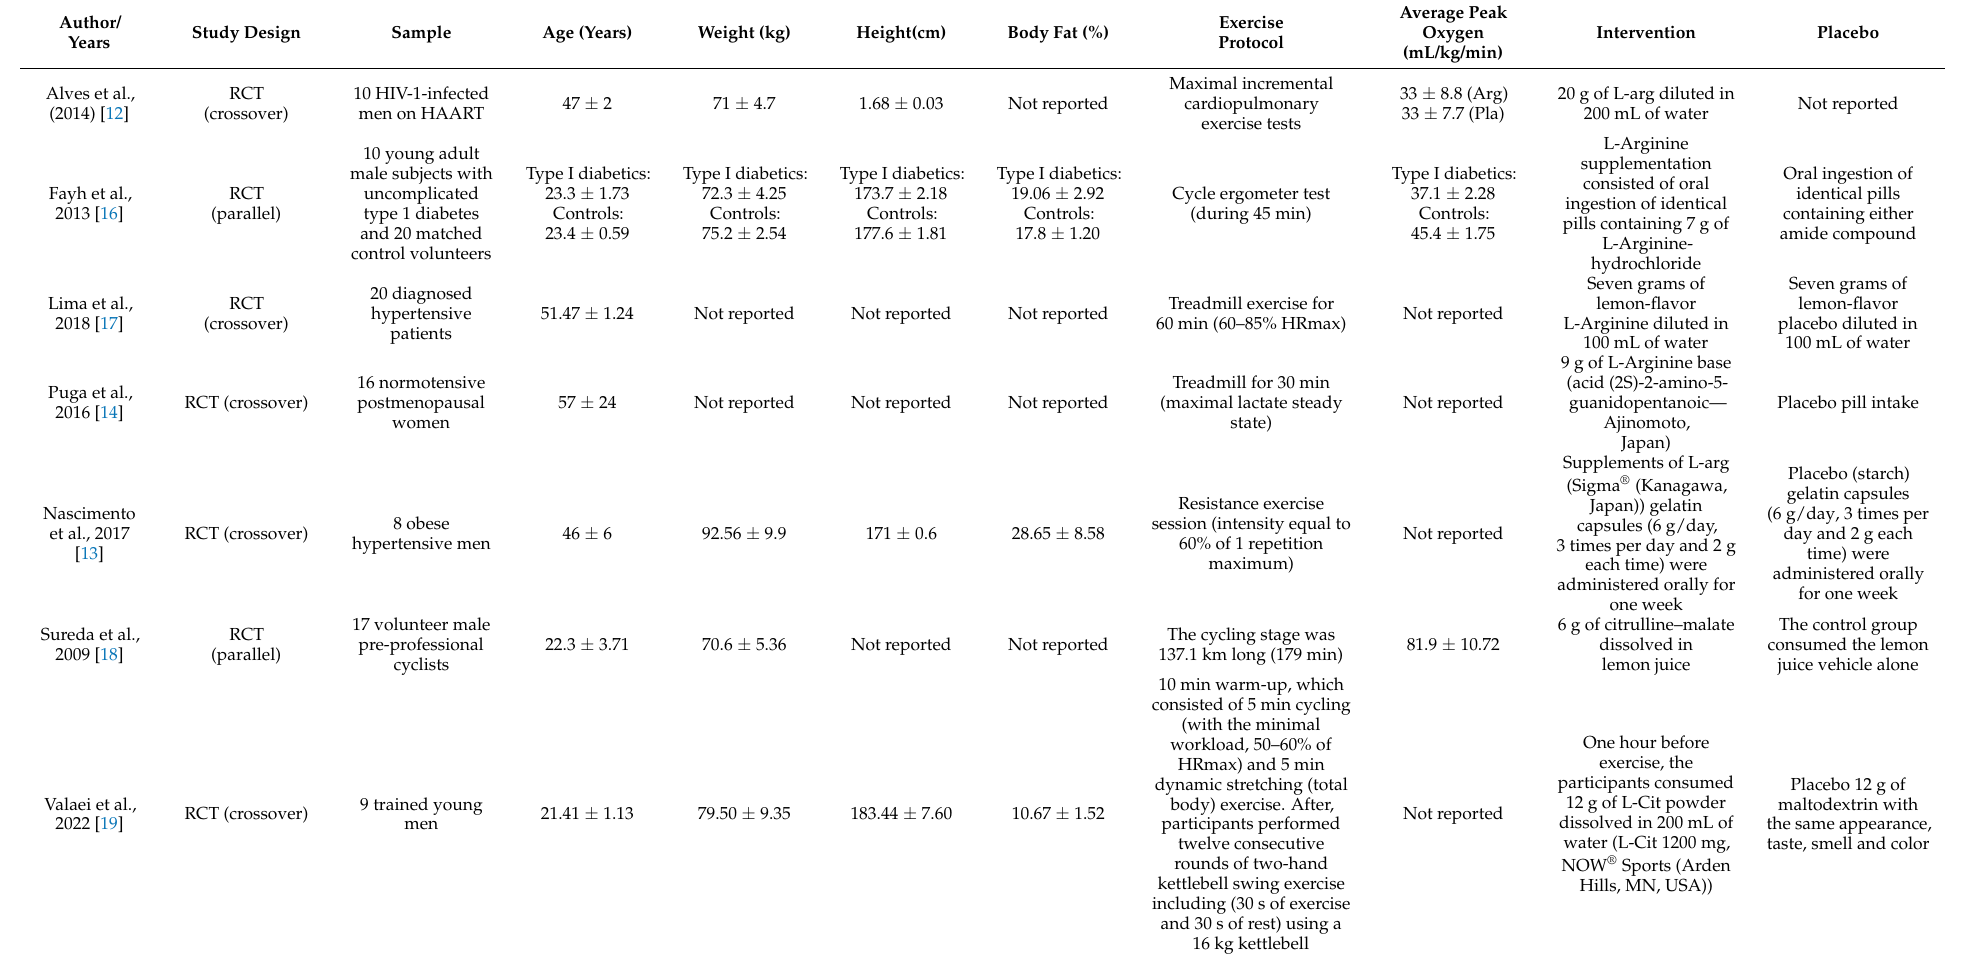
Table 1. Description of the characteristics of the study population of articles by author and year, sample, age (years), weight (kg), height (cm), body fat (%), (mean ± SD or, [min-max]), exercise protocol, average peak oxygen